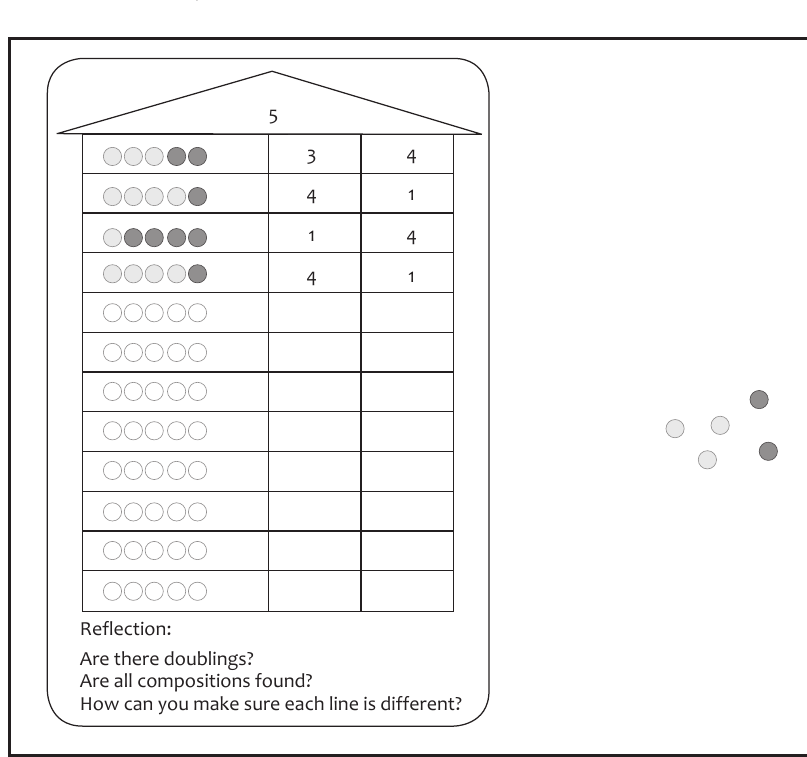
Figure 6: Finding all parts to a